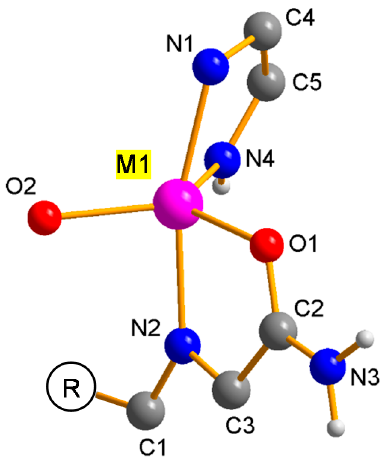
Figure 3. Asymmetric unit of isostructural IFPs in general, showing the coordination environment of the metal center and the bridging mode of inter-connecting Linker L.